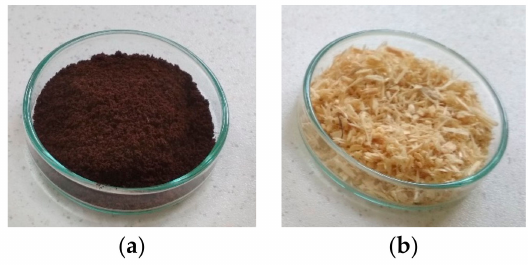
Figure 1. Input material: ( a ) spent co ff ee grounds and ( b ) sawdust.